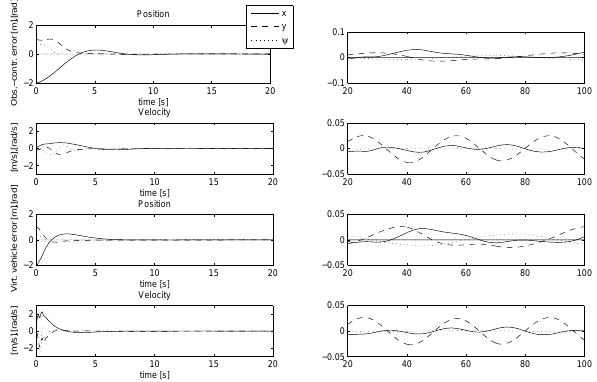
Figure 3: Nominal performance of the dynamic observer scheme (top two rows) and kinematic observer scheme (bottom two